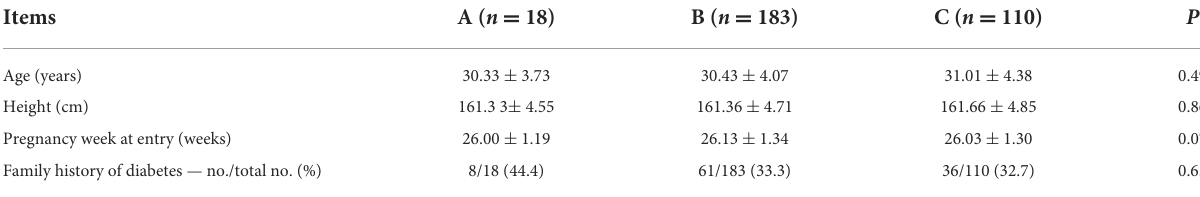
TABLE 1 Comparison of the general data among the three groups (X ± s).